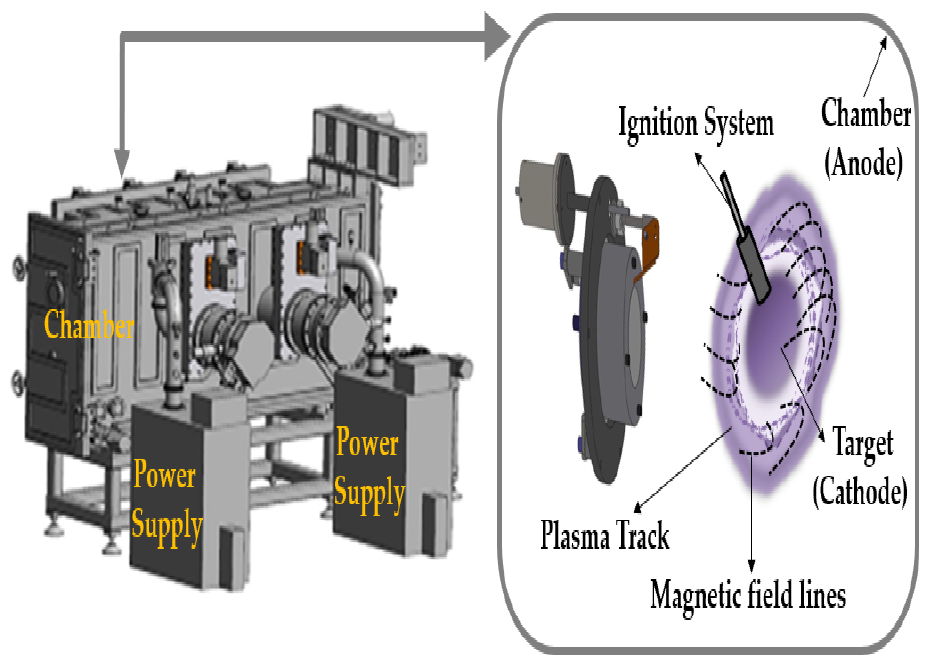
Figure 2. Illustration of cathodic arc plasma (CAP) technique.